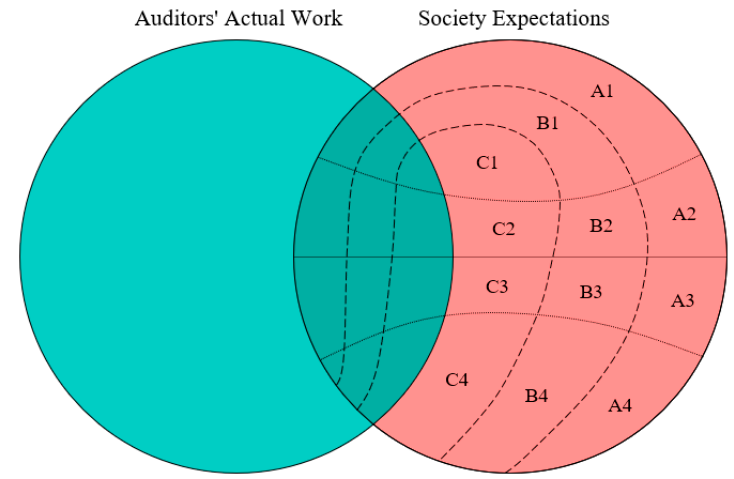
Figure 1. Auditing expectation gap divided into three elements and four key areas. Source: own elaboration based on analysed literature.